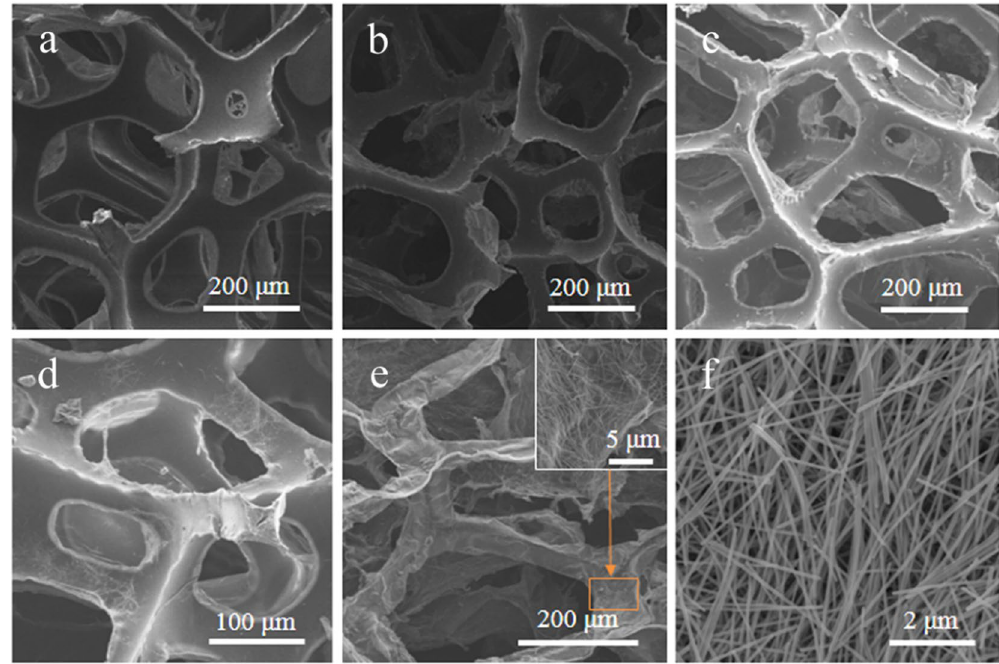
Figure 4. ( a ) SEM image of PU foam. ( b ) PG. ( c ) PU based graphite/AgNWs (1:1) hybrid foam. ( d ) PU based AgNWs foam. ( e ) PU based graphite/AgNWs (1:1) hybrid foam after removal of polymer-templates. ( f ) SEM image of